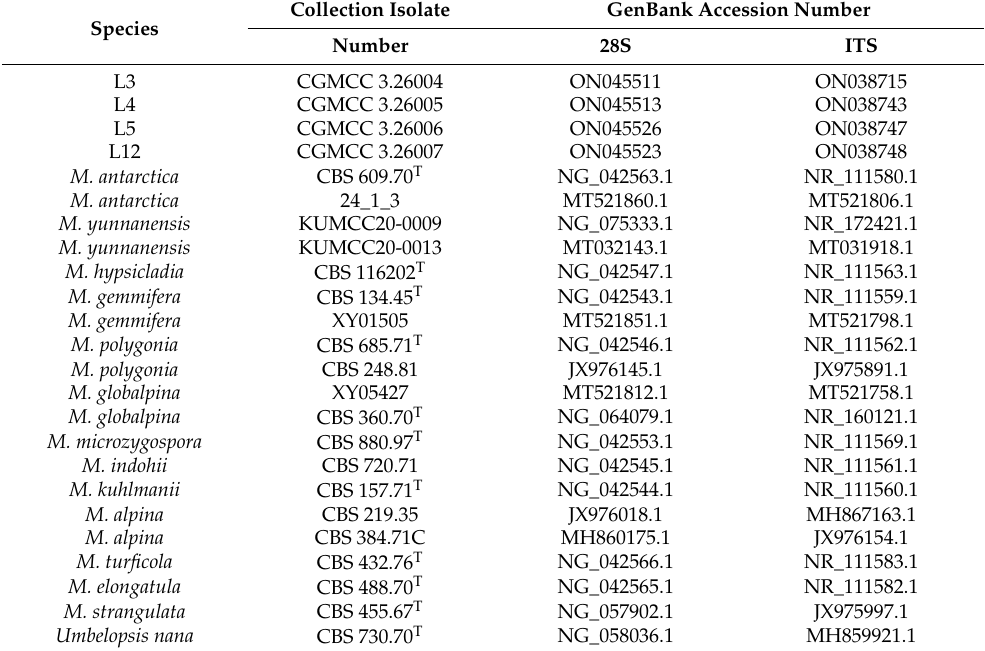
Table 1. Strains used in the molecular phylogenetic analysis in this